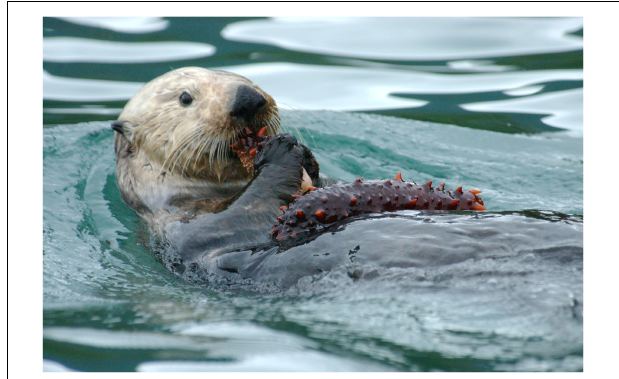
FIGURE 1 | Sea otter feeding on a California sea cucumber ( Apostichopus californicus ). Image by R. Davis taken under the authority of United States Fish and Wildlife Service LOC